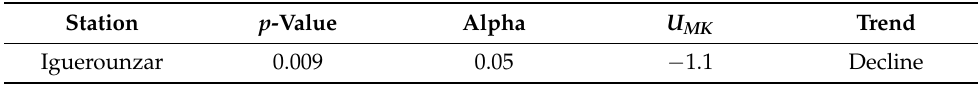
Figure 4. ( a ) Annual precipitations and ( b ) Pettitt test results. Table 2. The results of the Mann–Kendall